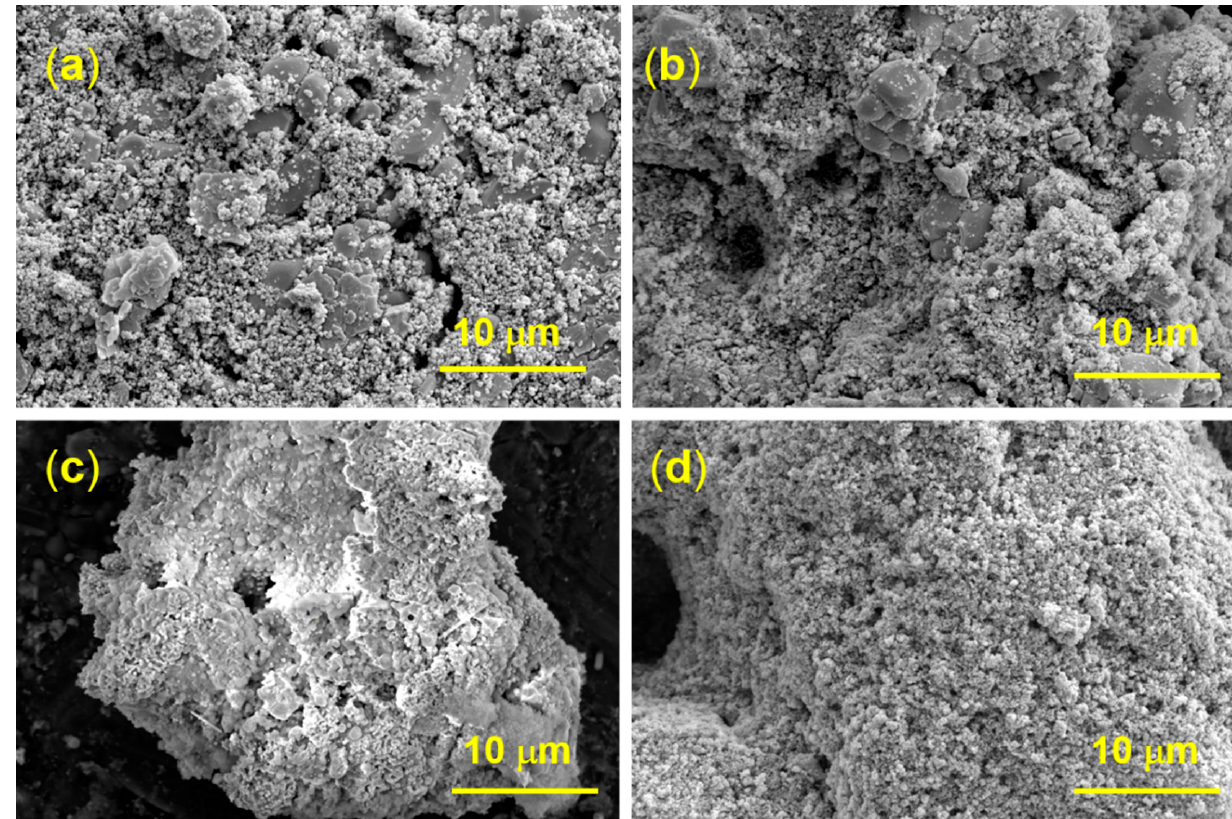
Figure 5. SEM images of the NiWO 4 + 2Mg + 2C mixtures cooled down at different temperatures: ( a )—initial mixture, ( b )—720 °C, ( c )—830 °C and ( d )—1000 °C.